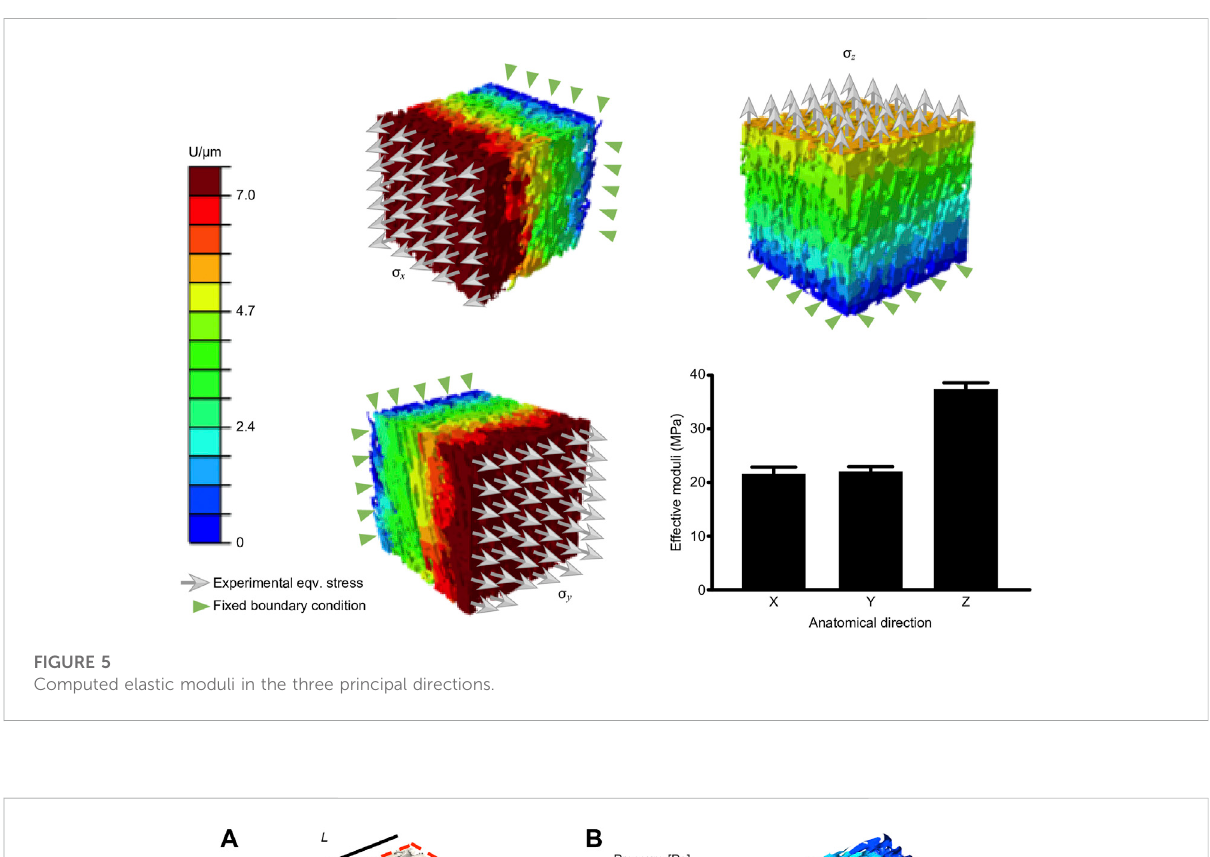
FIGURE 5 Computed elastic moduli in the three principal directions.